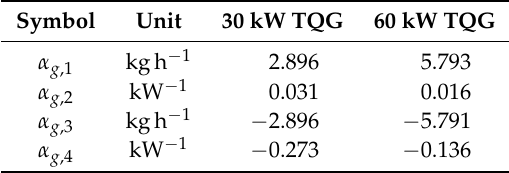
Table 1. Thirty kW and 60 kW TQG parameters for the model of Equation (2) used in the example of Section